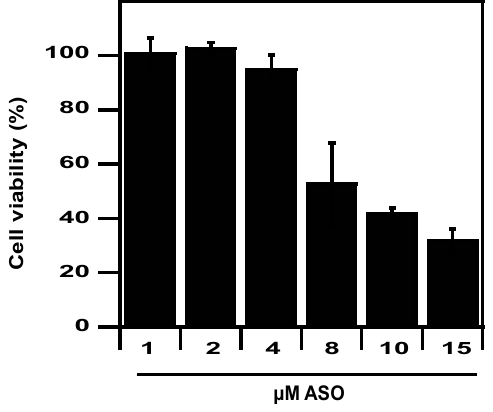
Figure 5. Cytotoxicity of LPN towards eukaryotic cells. Cell viability of dendritic cells 24 h after transfection with LPN complexes using increasing concentrations of ASO.